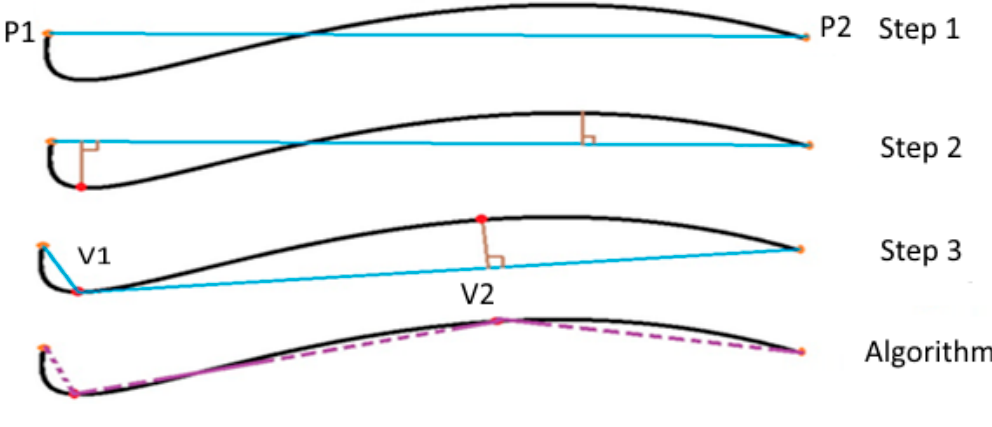
Figure 5. The different stages of the Douglas-Peucker algorithm.